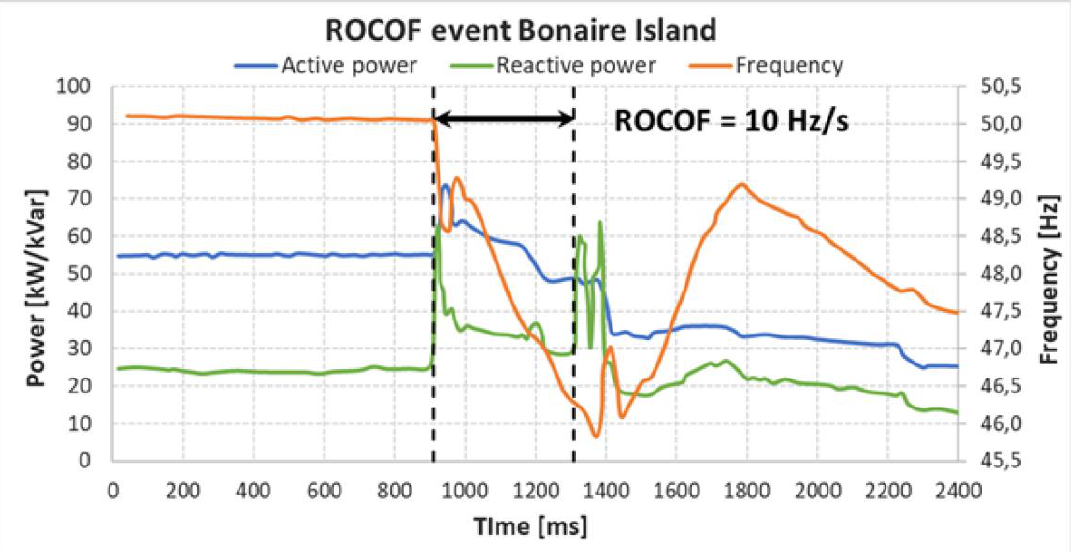
Figure 1. Fast rate of change of frequency (ROCOF) Event Triggered by a 12 kV short circuit fault on the Bonaire island grid—(red) system frequency y-axis on the right side, (blue) system active power consumption, (green) system reactive power consumption